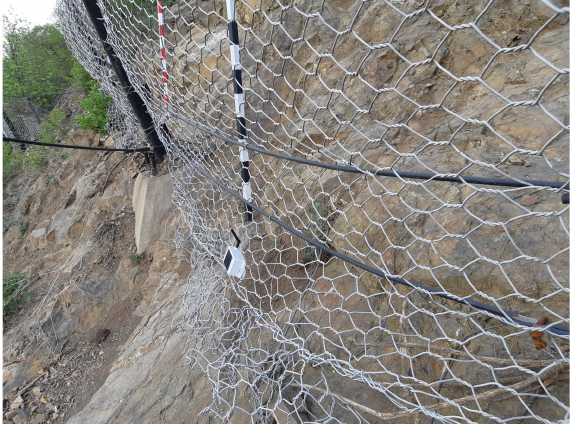
Figure 12. View of the second-generation accelerometer wireless sensor node in the plastic box with solar